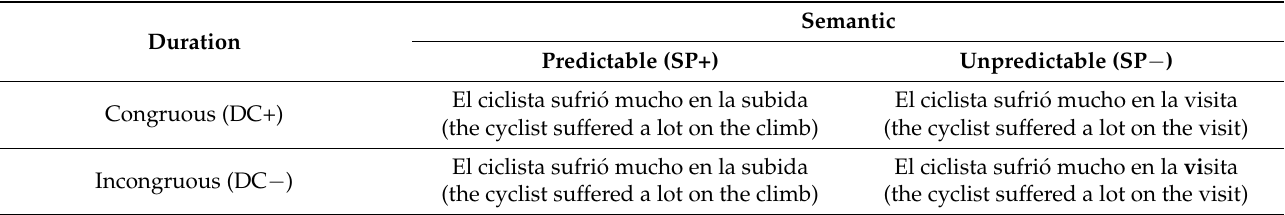
Table 1. Example of the stimuli in the four experimental conditions. Semantic Duration Predictable (SP+) Unpredictable (SP − ) El ciclista sufri ó mucho en la subida El ciclista sufri ó mucho en la visita Congruous (DC+) (the cyclist suffered a lot on the climb) (the cyclist suffered a lot on the visit) El ciclista sufri ó mucho en la subida El ciclista sufri ó mucho en la vi Incongruous (DC − ) (the cyclist suffered a lot on the climb)